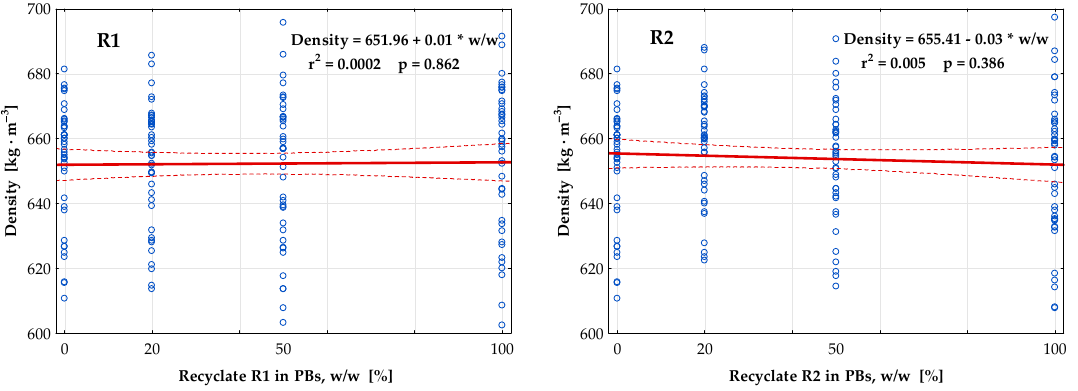
Figure 3. Density of PBs containing di ff erent types (R1 or R2) and amounts of wood recyclates. The moisture properties of the PBs, i.e., the thickness swelling (TS) and water absorption (WA), were already more scattered: TS-2h ranged from 3.32% for PB-R2-100 to 6.05% for PB-C; TS-24h ranged from 9.72% for PB-R2-100 to 23.95% for PB-C; WA-2h ranged from 10.80% for PB-R2-100 to 27.59% for PB-C; WA-24h ranged from 33.46% for PB-R2-100 to 68.52% for PB-C (Tables 3 and 4). The e ff ect of